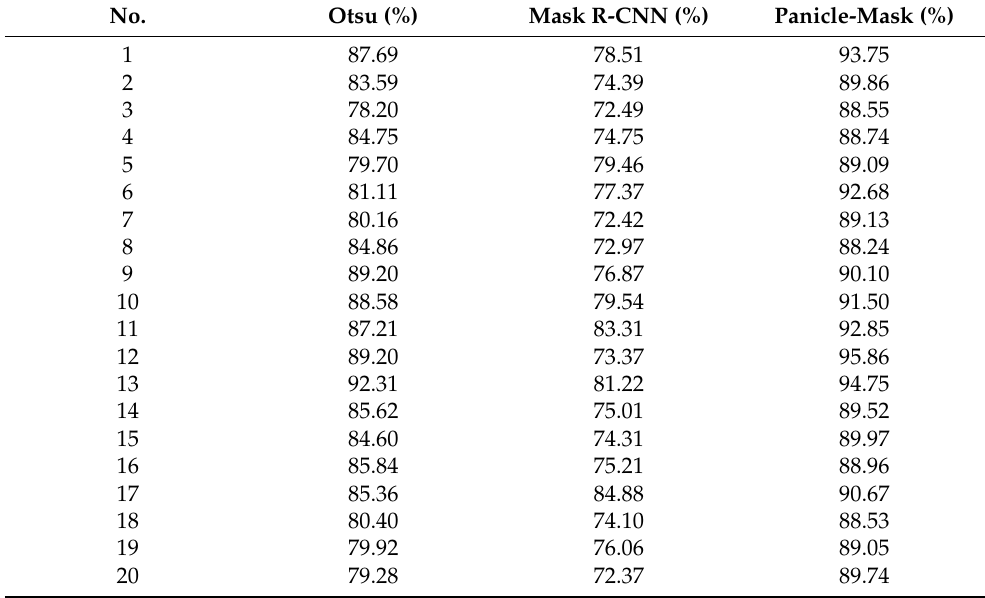
Table 2. SSIM values for the different